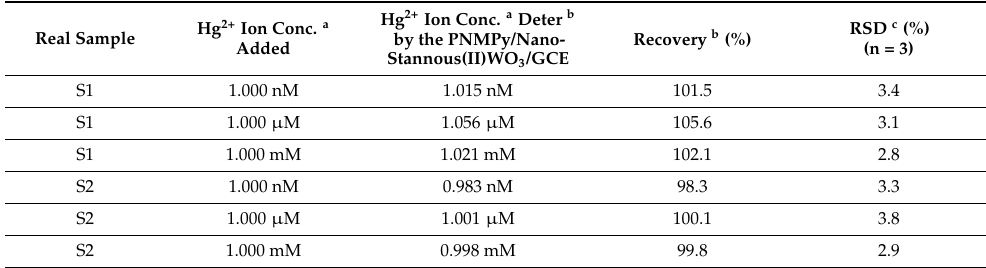
Table 1. Analysis of real environmental samples with PNMPy/nano-Stannous(II)WO 3 /Nafion/GCE by electrochemical approach.